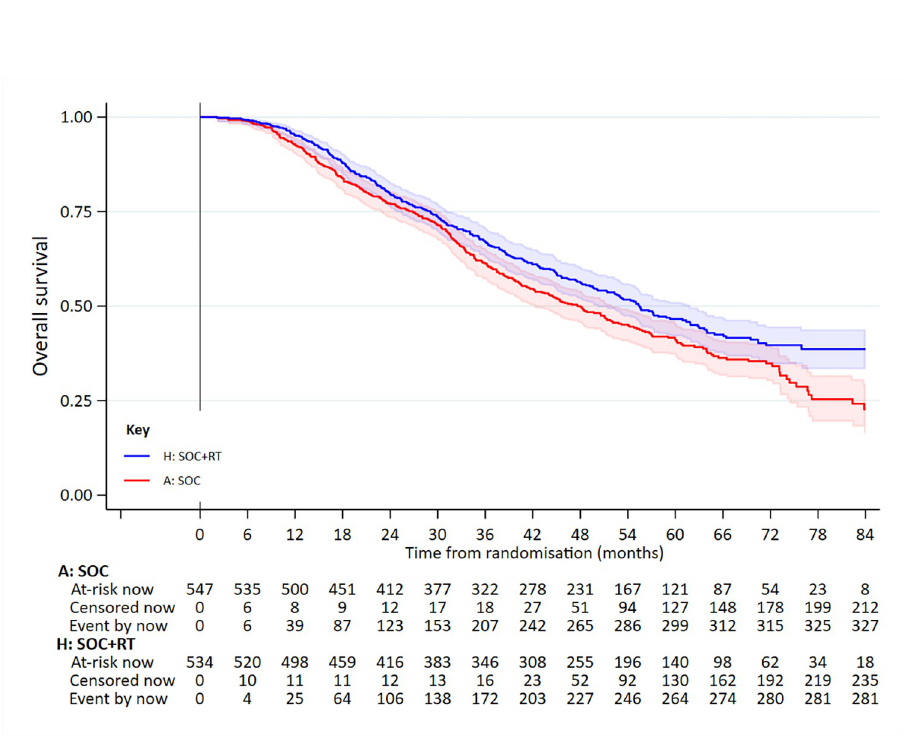
Fig 6. OS in patients nominated for daily RT (55 Gy/20 f) prior to randomisation. Adjusted HR = 0.83 (95% CI 0.71 to 0.97; p = 0.022). HR, hazard ratio; OS, overall survival; RT, radiotherapy to the prostate; SOC, standard of care.